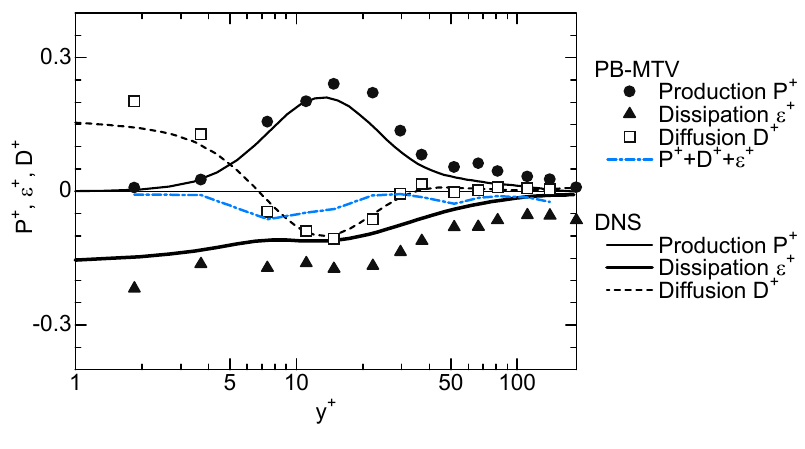
Fig. 12 Turbulence kinetic energy